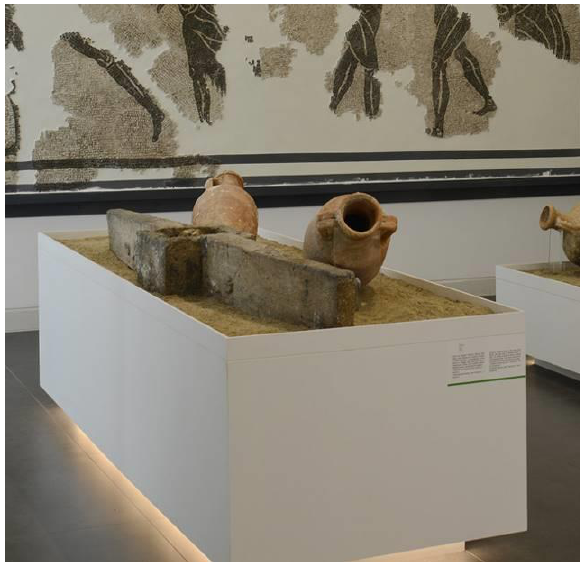
Figure 2. Dressel